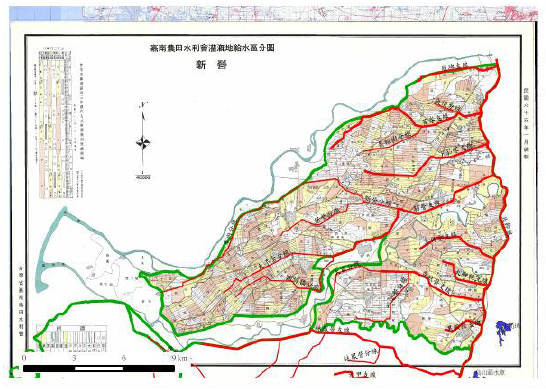
Figure 5. Mapping of the 1977 irrigation system